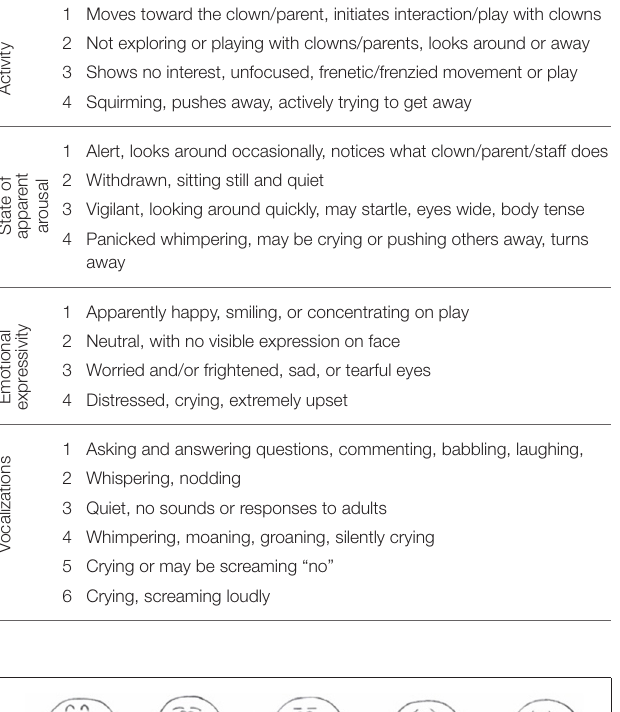
TABLE 3 | The mYPAS scoring criteria.